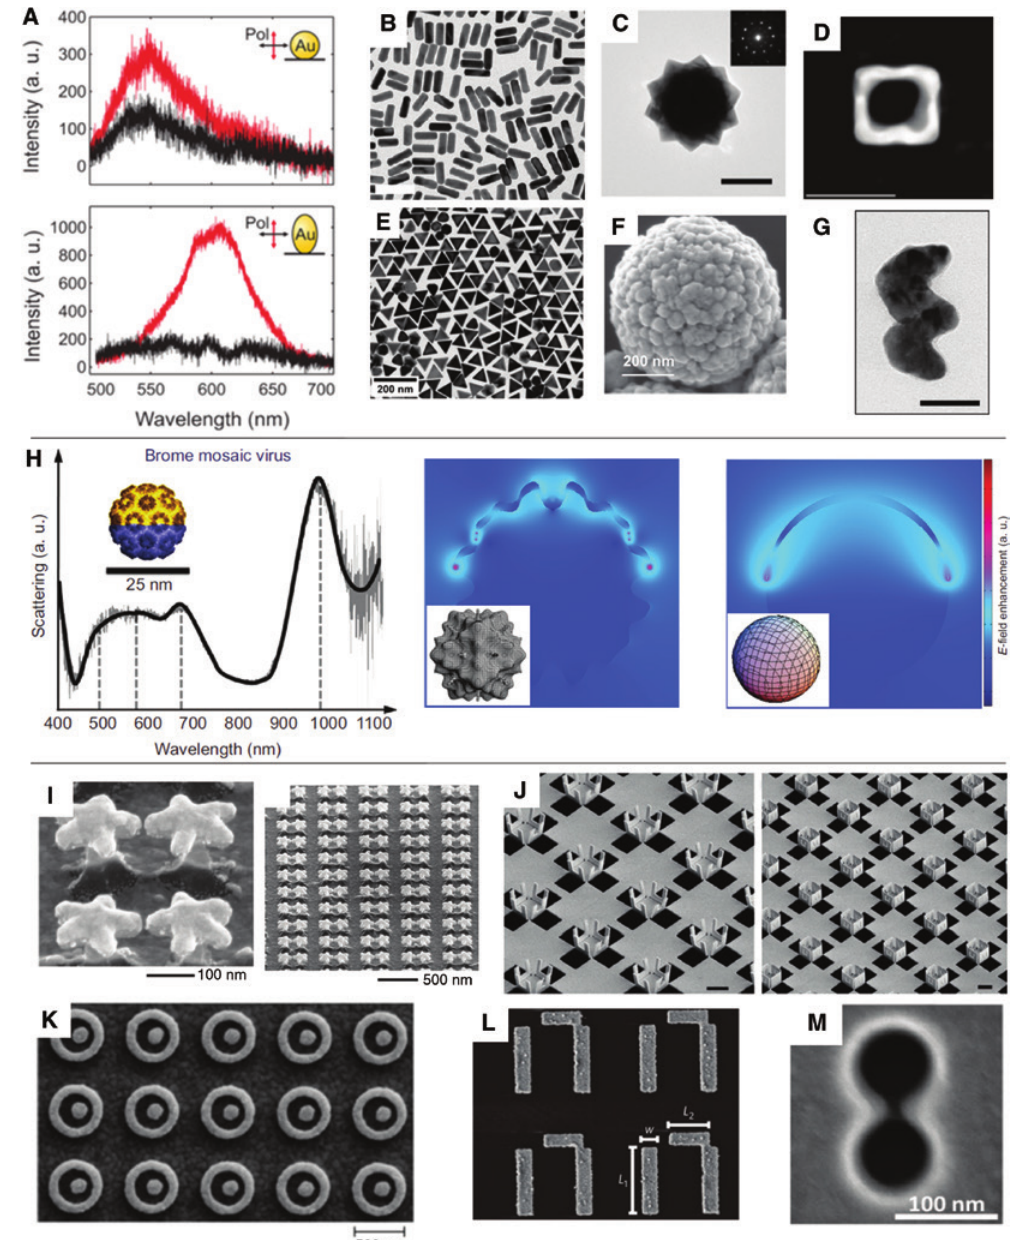
Figure 2: Shape and properties of plasmonic nanostructures. (A) Scattering spectra under linearly polarised dark-field excitation for a spherical 80-nm gold nanoparticle (upper panel) and elongated particle after melting the spherical particle to 110 nm × 68 nm (lower panel). The polarisation of the white excitation light is perpendicular